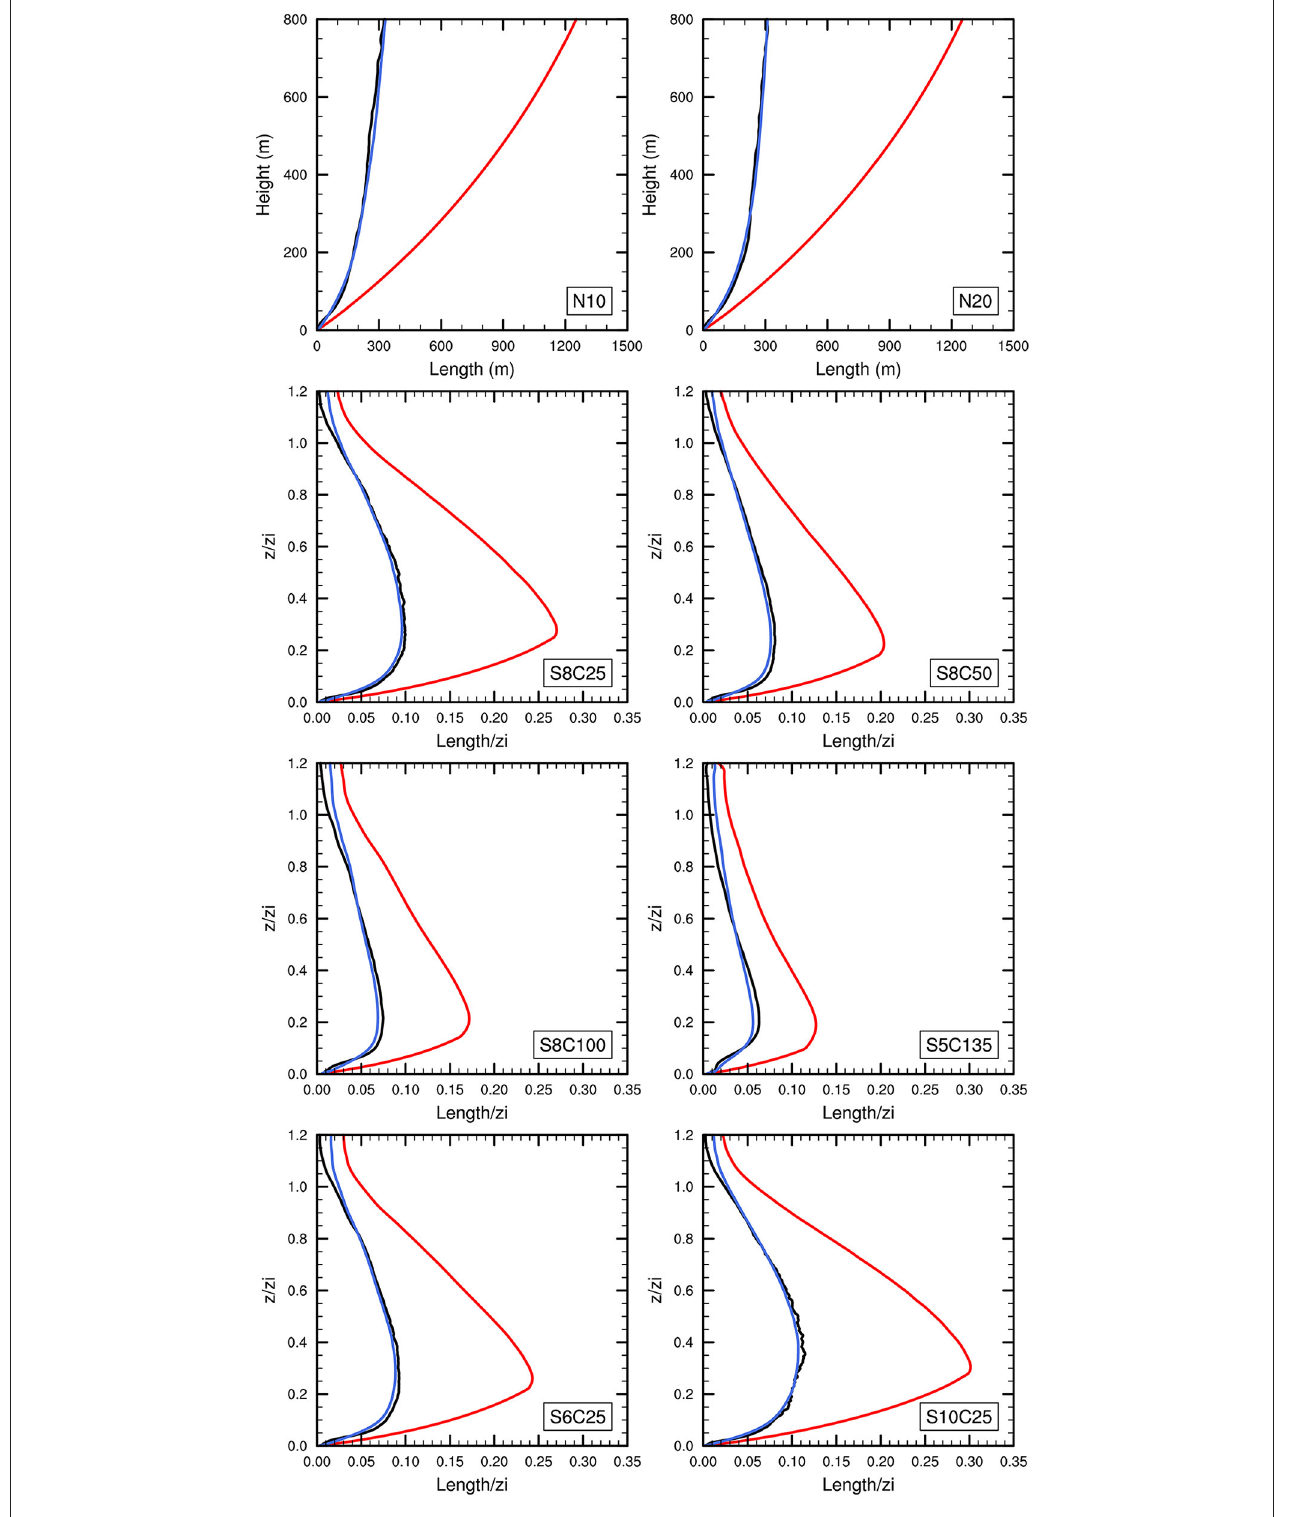
FIGURE 3 | Mixing length L m profiles from neutrally stratified (weak N10 and strong N20 geostrophic wind speed, see Table 1 ) and stably stratified (S8C25, S8C50, S8C100: weak to strong surface cooling; S6C25 and S10C25: weak to strong geostrophic wind speed; S5C135 weak geostrophic wind speed and strong surface cooling; see Table 1 ) LESs: the reference length L K / C m from Equation (10) (black), the diagnosed BL89 length (red), and the diagnosed BS length (blue). Profiles are scaled by the boundary-layer height z i , except for the neutral atmospheres (N10 and N20).